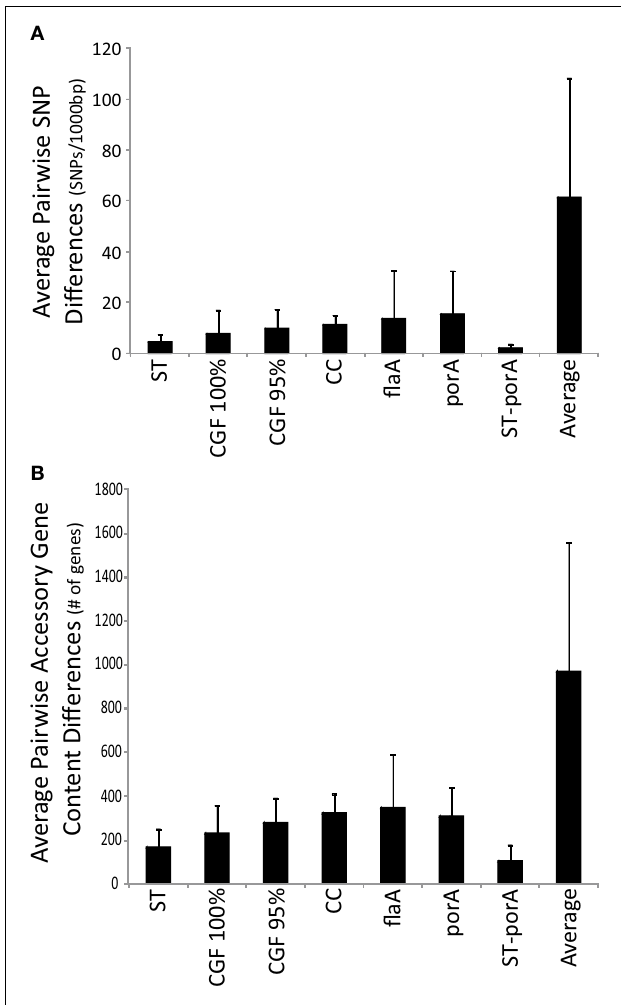
FIGURE 4 | Genotypic clusters are comprised of strains with high genomic similarity. Genotypic clusters obtained using five different molecular typing methods were analyzed for (A) average SNP rates or (B) accessory gene content differences in order to assess intra- and inter-cluster core and accessory genetic similarities, respectively. Although all methods generated genotypic clusters sharing higher core and accessory genetic similarities than expected by chance alone, multi-locus methods led to genotypic clusters with higher genetic